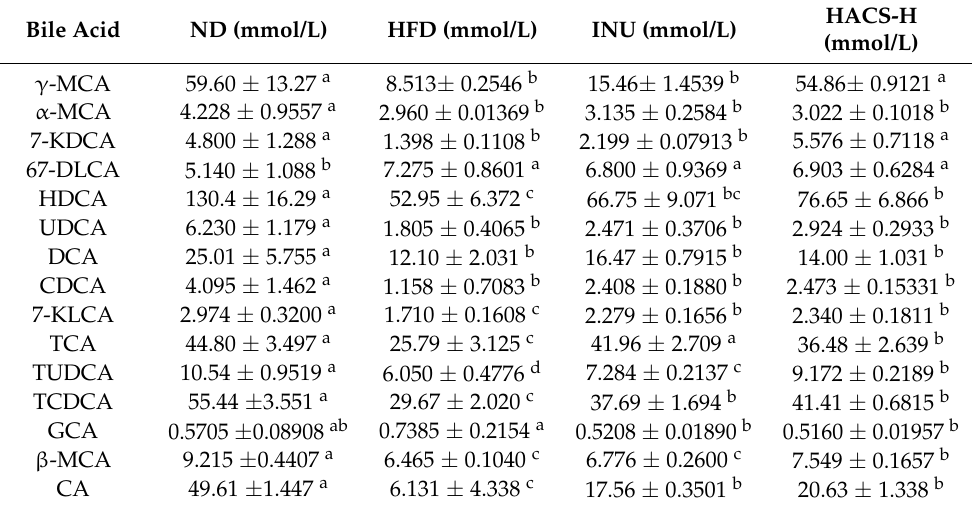
Table 1. The circulating levels of bile acids in